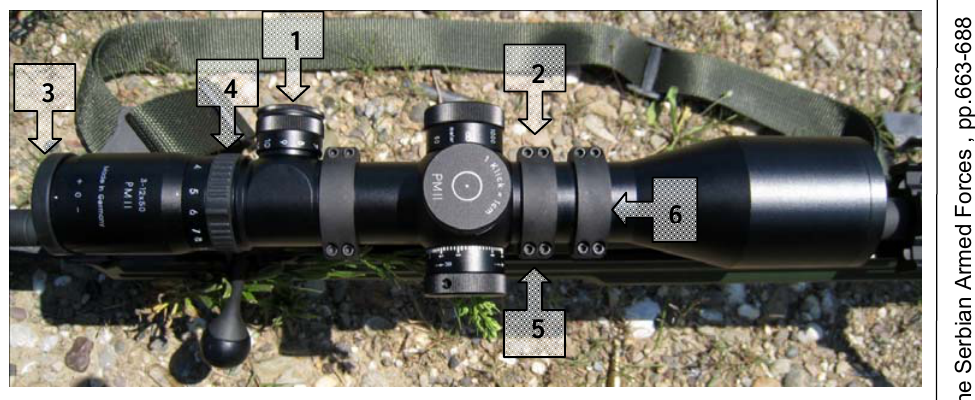
Figure 7 – Optical sight: 1. system for reticle illumination, 2. parallax mechanism, 3. diopter adjustment ring, 4. magnification adjustment ring, 5. elevation mechanism, and